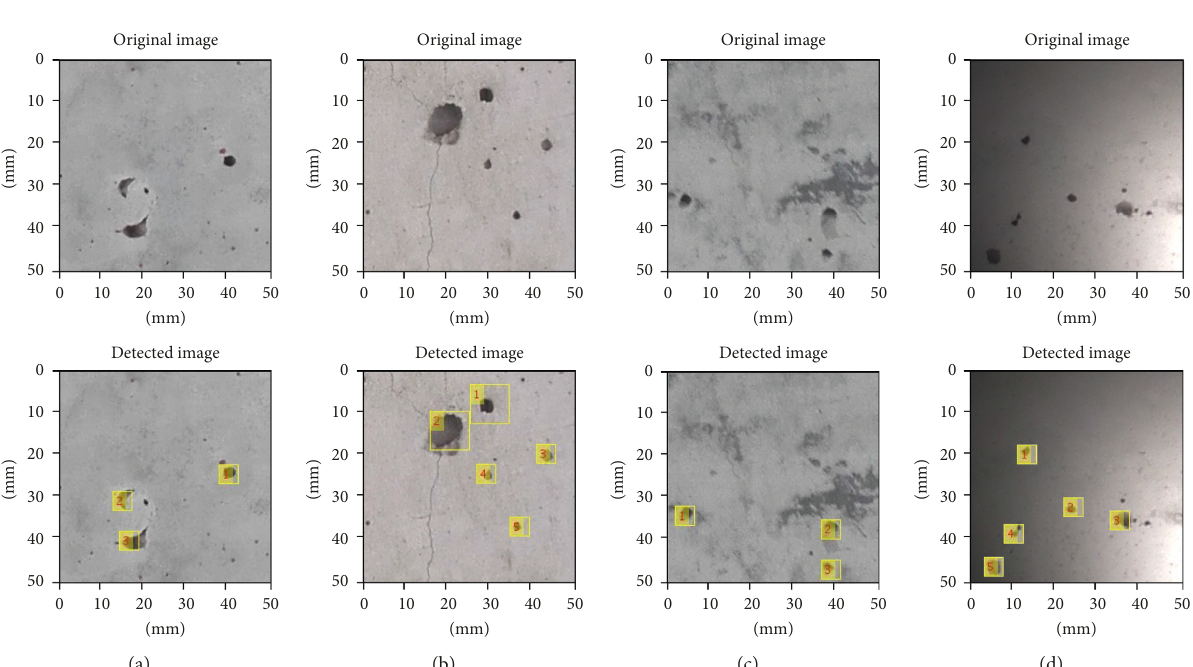
Figure 10: Results of image testing using the trained DCNN. Concrete surface with (a) only bugholes, (b) both bughole and crack, (c) both bughole and color-difference, and (d) nonuniform